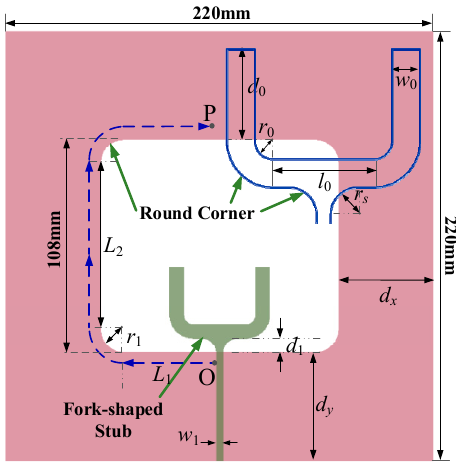
Figure 2. Geometry and configuration of the normal printed WS antenna with a round corner on the stub and ground plane.